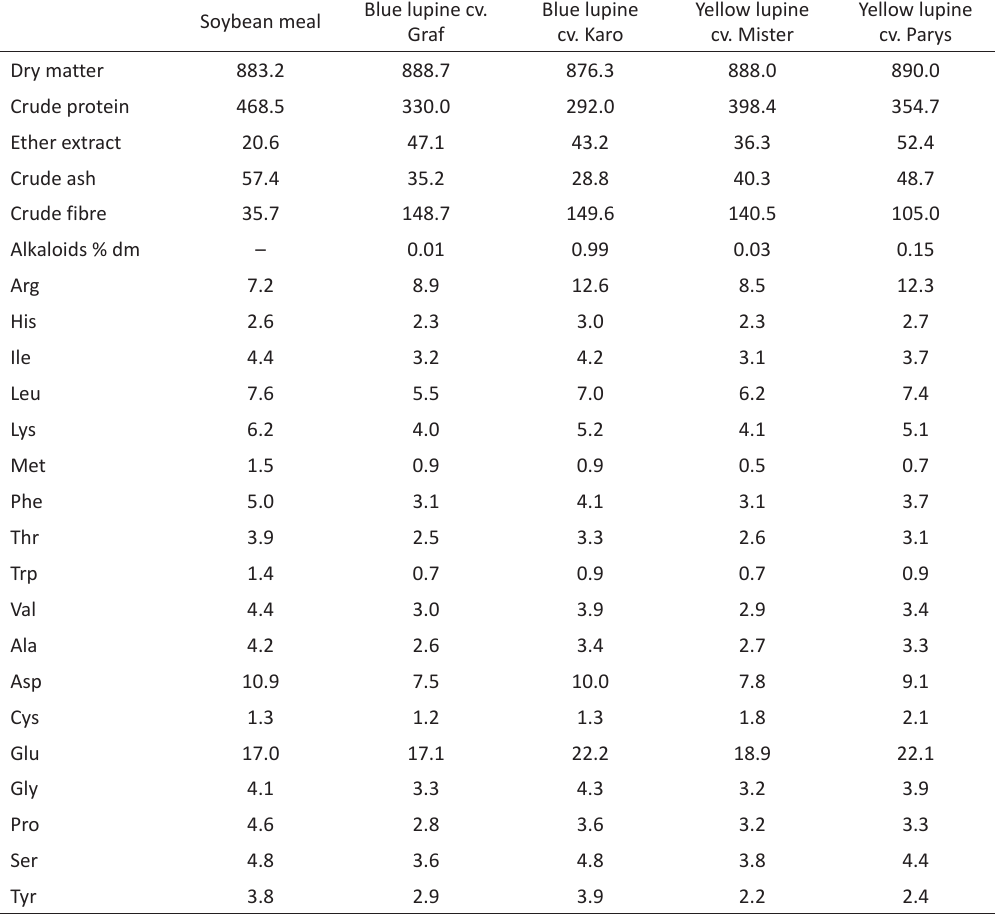
Table 4. Chemical composition (g kg -1 ) and amino acids content of seed protein (g 100 g -1 protein)